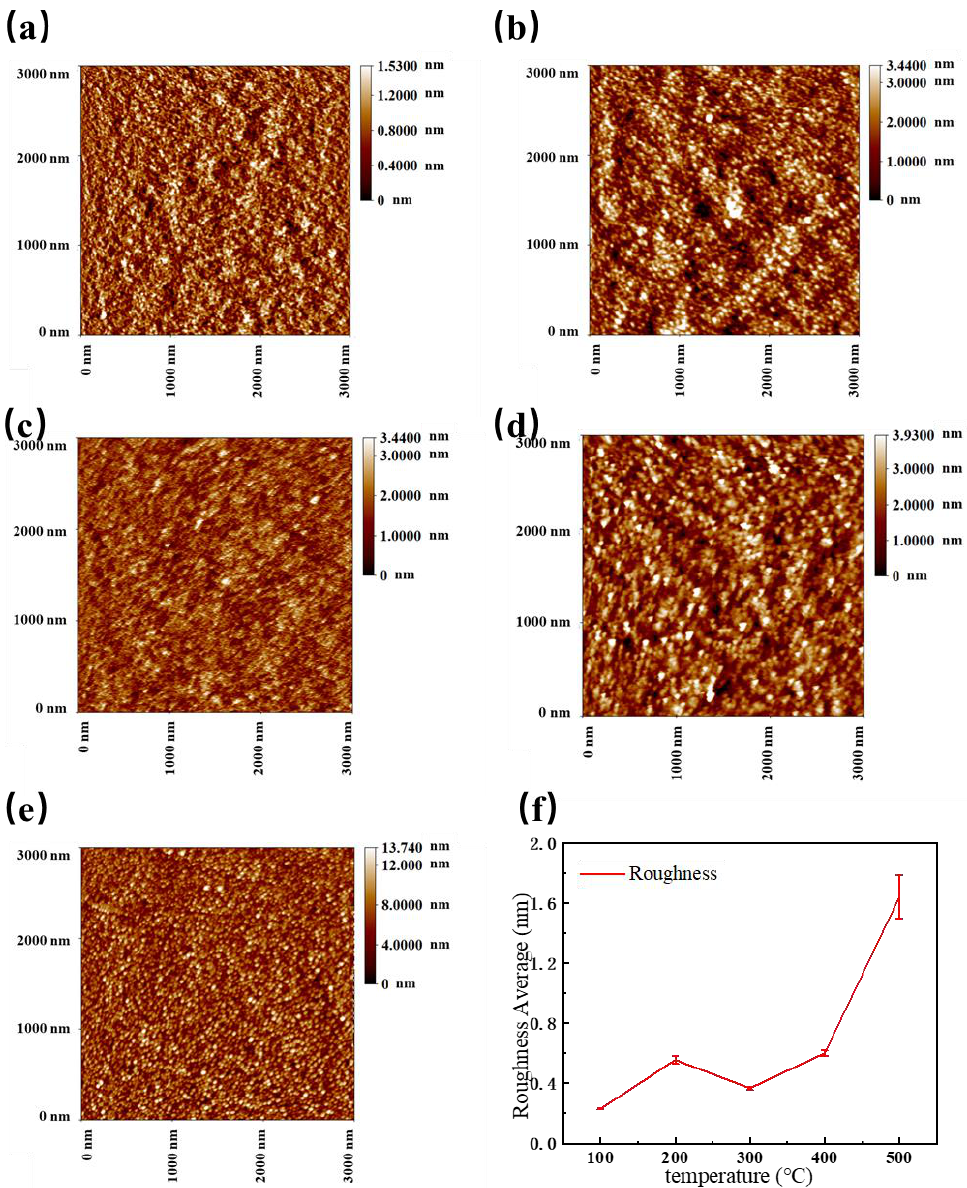
Figure 3. The atomic force microscope (AFM) images 3000 nm × 3000 nm and the roughness of NiO films. ( a ) 100 °C; ( b ) 200 °C; ( c ) 300 °C; ( d ) 400 °C; ( e ) 500 °C; ( f ) the roughness of NiO films, which are read by the support software of AFM.